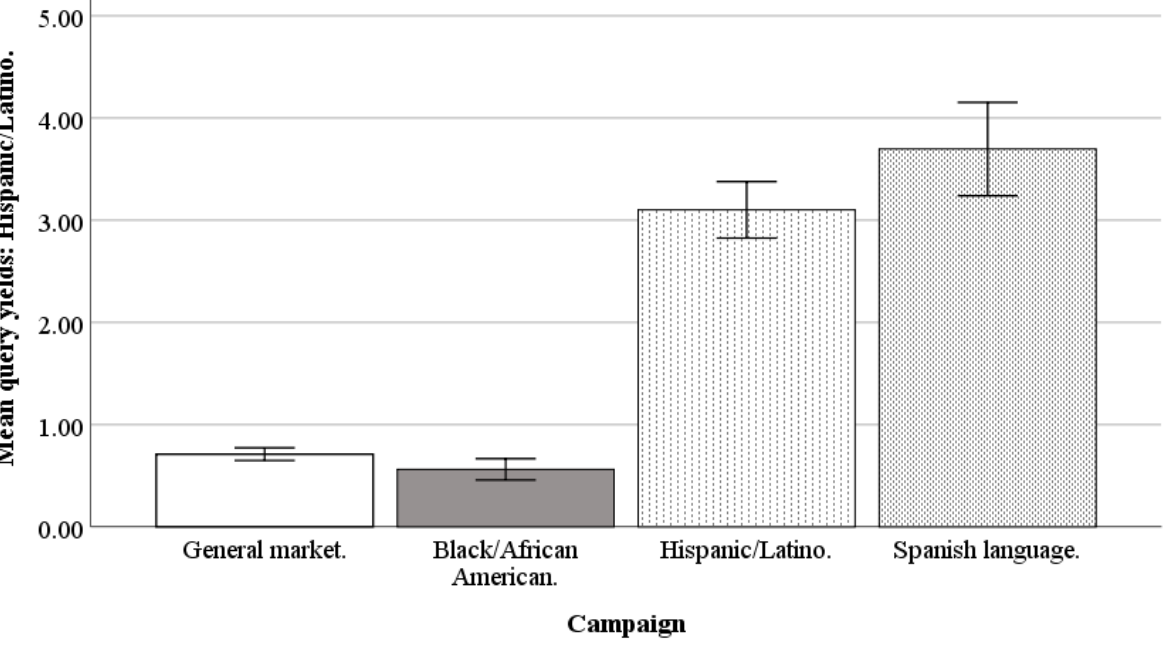
Figure 3. Mean query yields of Hispanics/Latinos for Facebook advertising